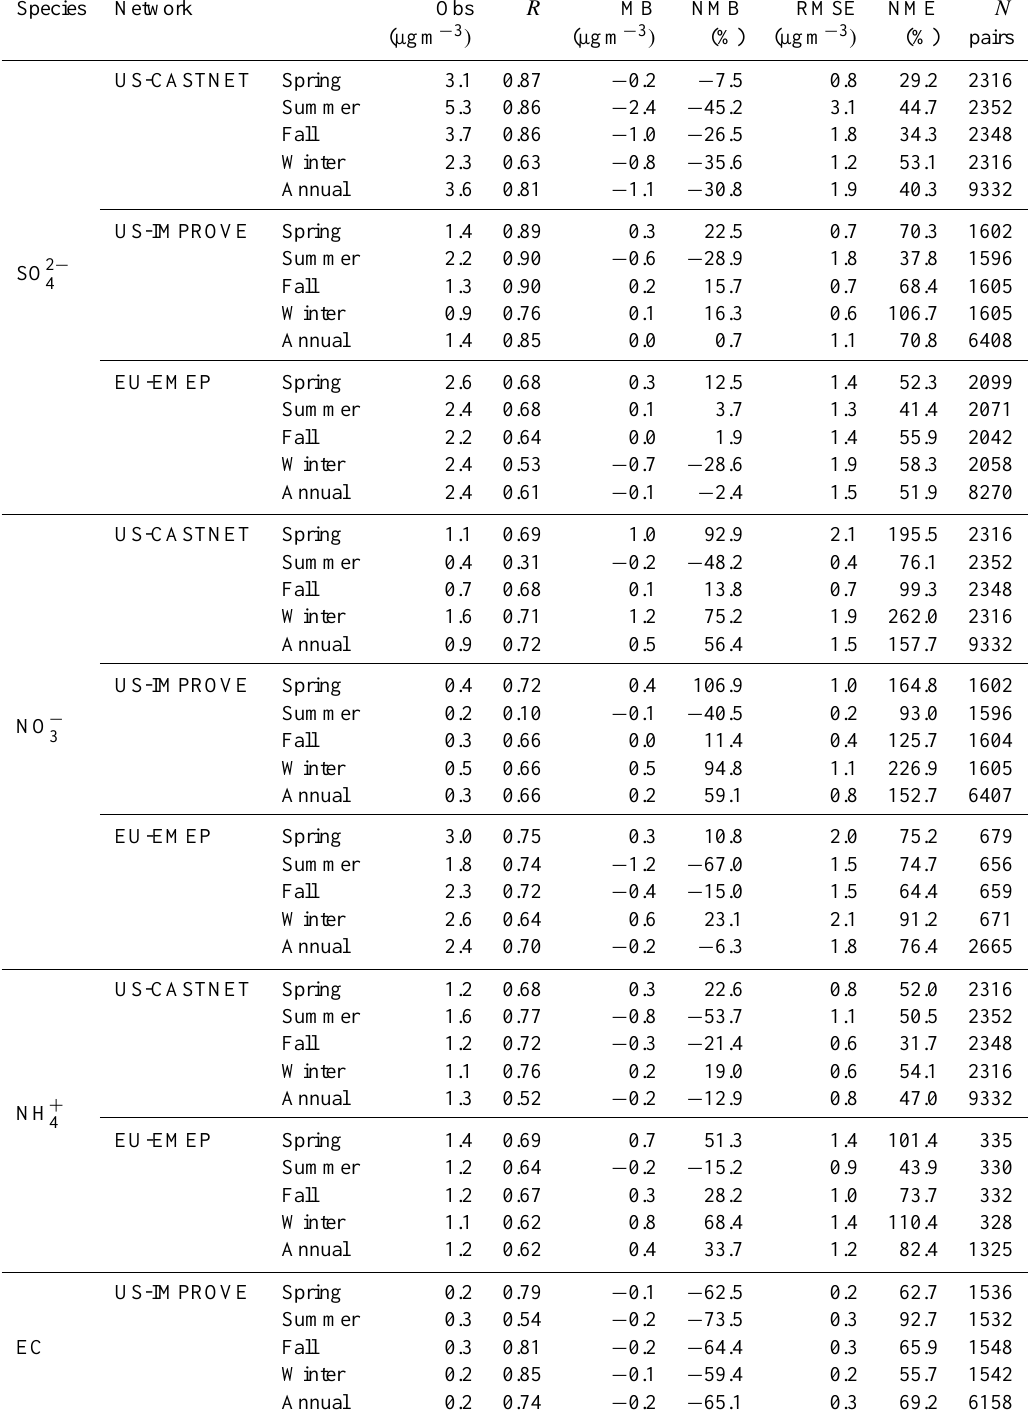
Table 2b. Model performance. Fine particles.